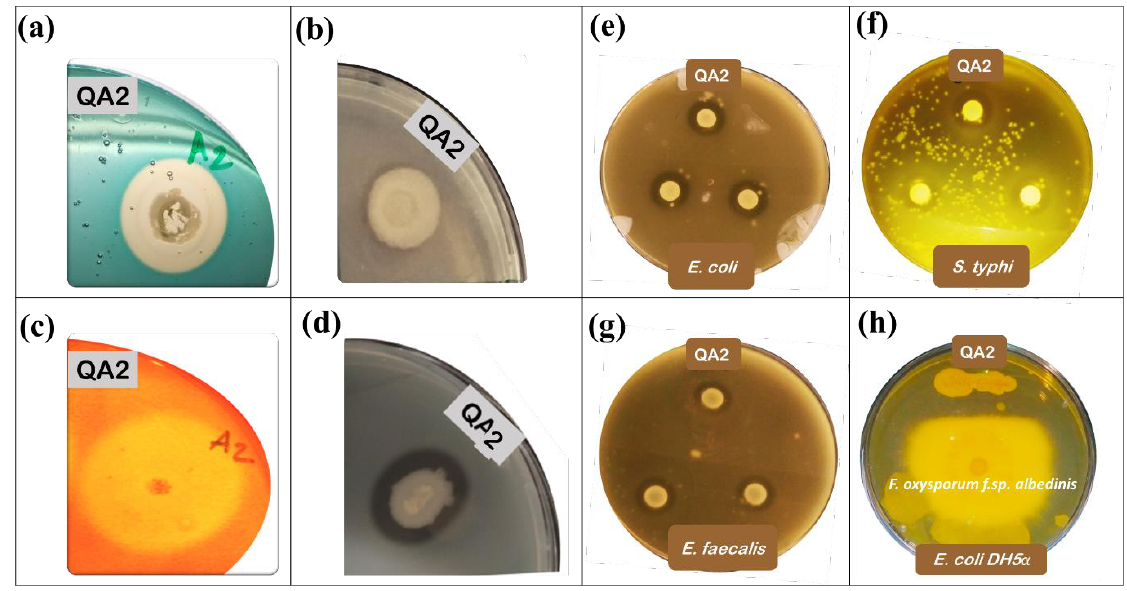
Figure 2. Schematic illustration showing the various tests performed on plates (Petri dishes with 9 mm in diameter) for the assessment of PGP traits of QA2 PSB. ( a ): Siderophore production, ( b ): ZnO solubilization, ( c ): Cellulase production, ( d ): Protease production, ( e ): Antibacterial activity against E. coli , ( f ): Antibacterial activity against S. typhi , ( g ): Antibacterial activity against E. faecalis , ( h ): Antifungal activity against F. oxysporum f.sp. albedinis (above) and E. coli DH5α (below).